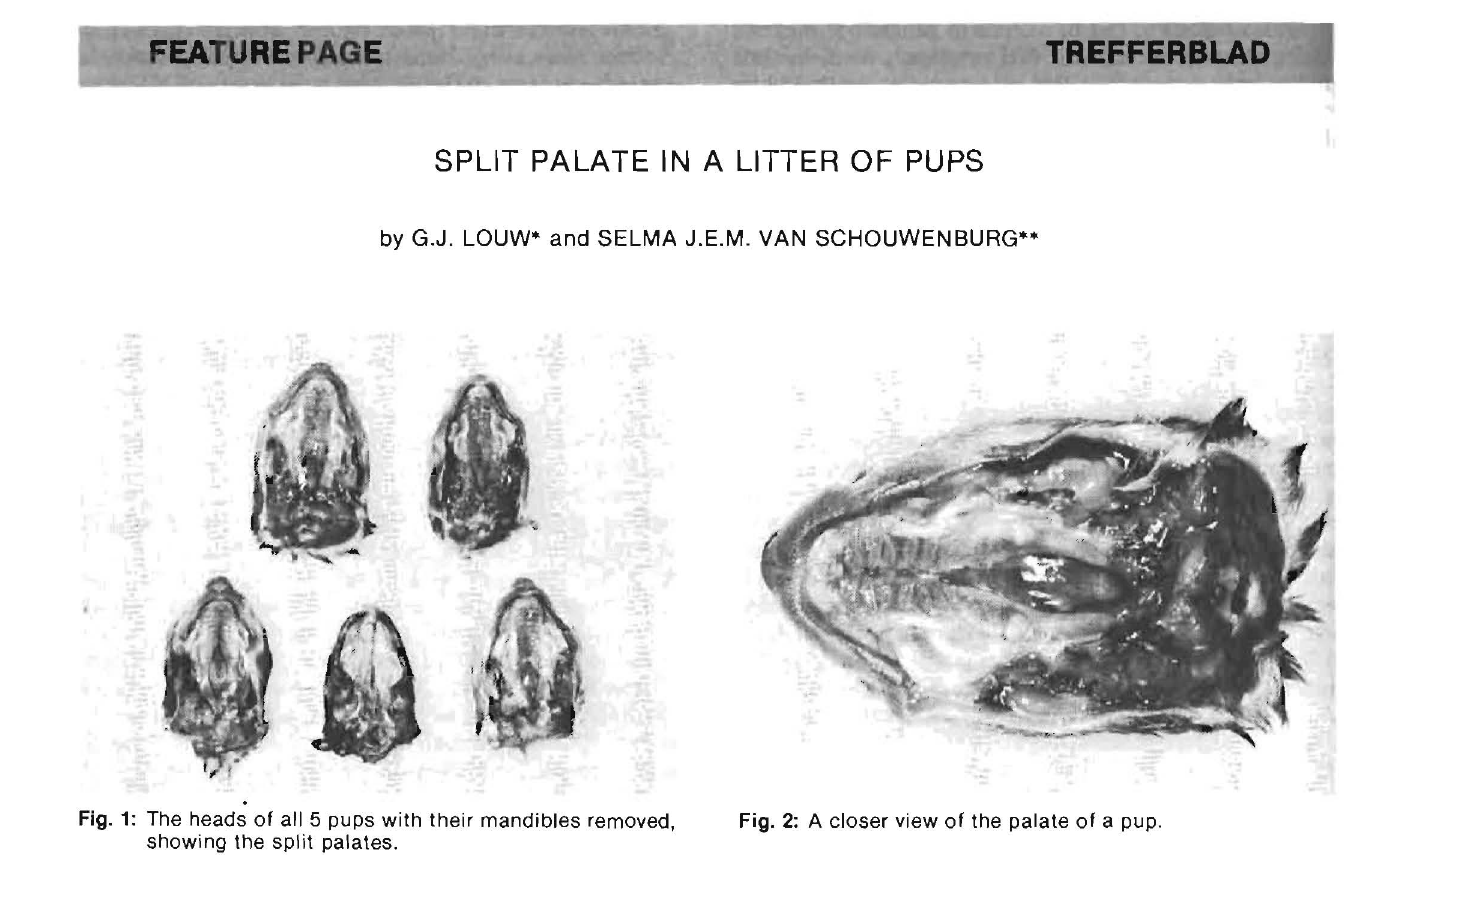
pups were euthanased. An examination of all 5 cadavers revealed a split palate in each animal (Fig. 1 & 2). In many domestic animals and in man, the fusion of the palate occurs approximately 1/4 - 112 of the way through the gestation period. If this were to be ex trapolated in this case, it may be assumed that fusion occurs at approximately 32 - 34 days of gestation in the